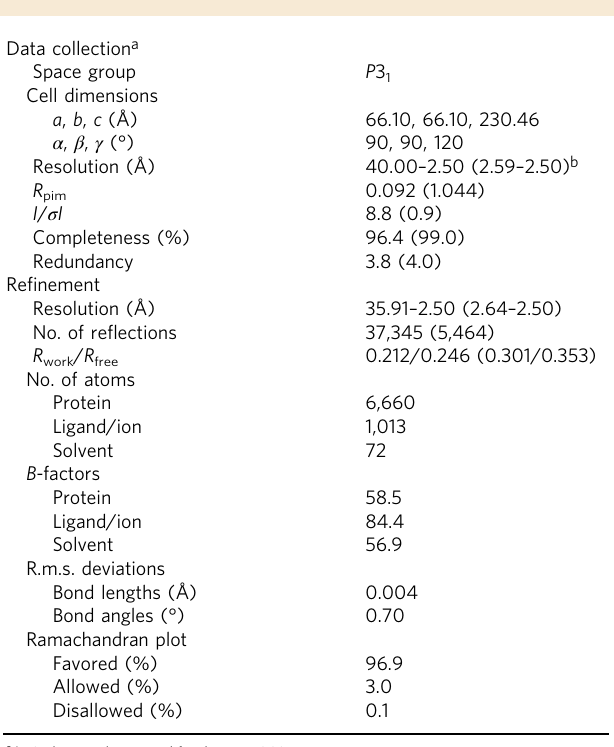
Table 1 Data collection and re fi nement